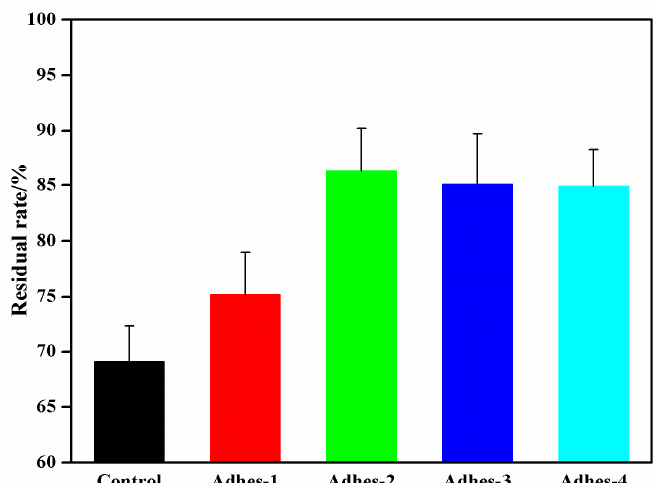
Figure 8. Insoluble rate of cured Camellia oleifera cake-protein adhesives. Note: Control, pure Camellia oleifera cake-protein hydrolysate; Adhes-1, the pure Camellia oleifera cake-protein adhesive; Adhes-2, Camellia oleifera cake-protein adhesive modified with DSP; Adhes-3, Camellia oleifera cake-protein adhesive modified with SPI; Adhes-4, Camellia oleifera cake-protein adhesive modified with casein.